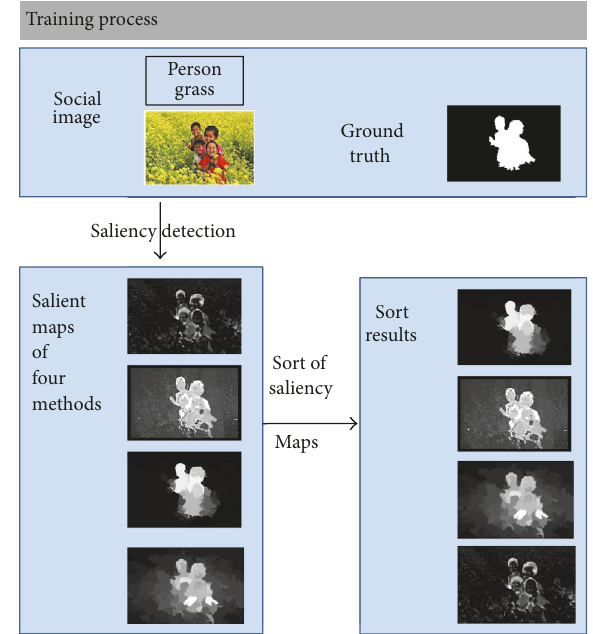
Figure 5: Training process.